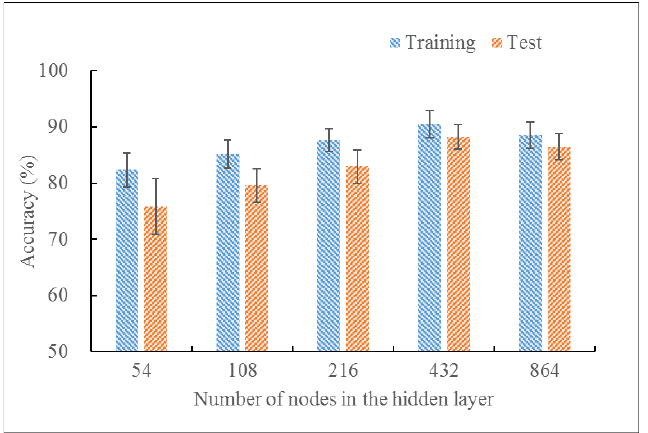
Figure 10. Recognition results of different numbers of neurons in the first hidden layer.